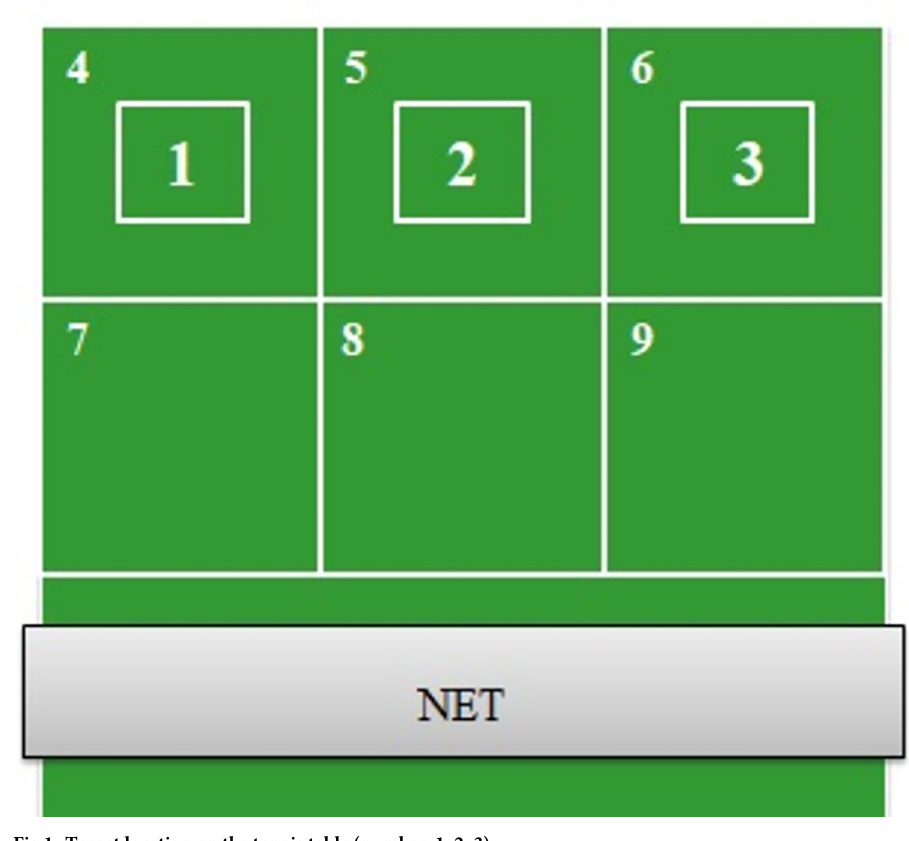
Fig 1. Target location on the tennis table (number: 1, 2,